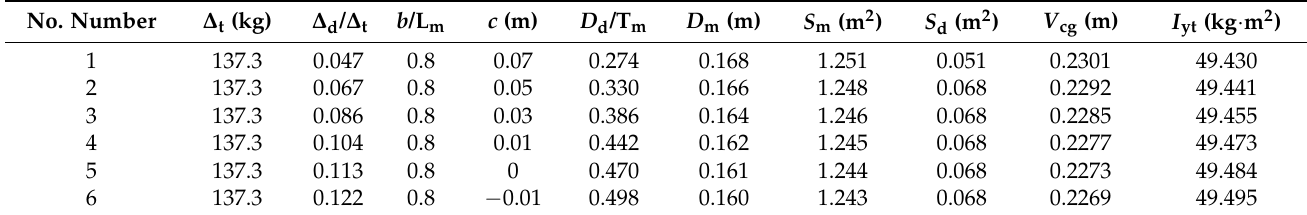
Figure 29 shows the vertical adjustment mode of the twin side ‐ hulls, in which the Figure 29. Vertical adjustment mode of the twin side-hulls. solid and dashed lines separately represent the two positions before and after adjustment, Figure 29. Vertical adjustment mode of the twin side ‐ hulls. d represents the waterline position relative to the Base line (BL) of the main hull, c is the Table 9. Six vertical locations of the side-hulls in the Table 9. Six vertical locations of the side ‐ hulls in the TFS.